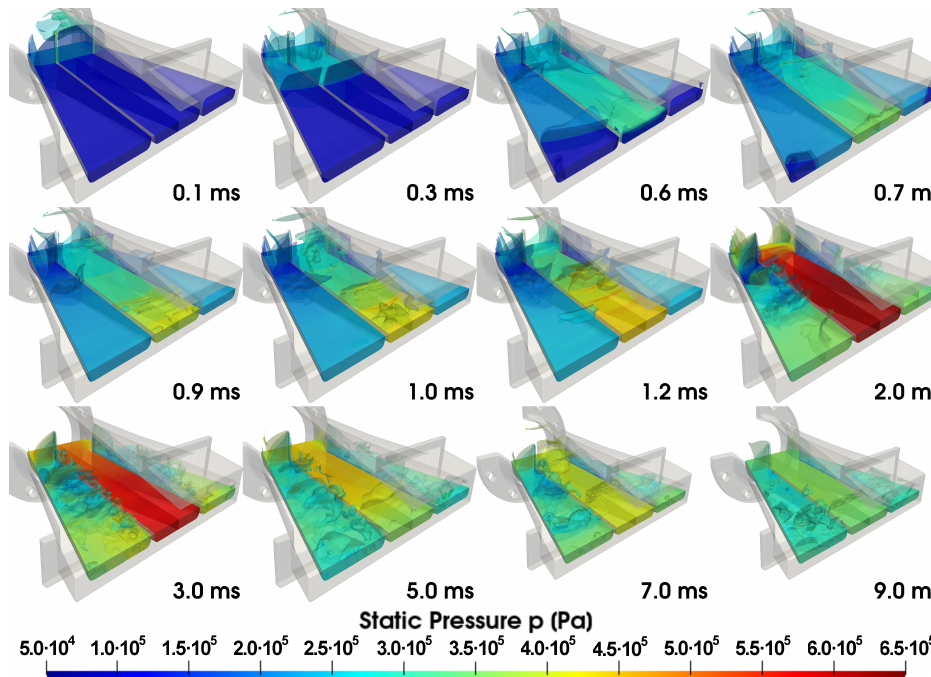
Figure 15. Snapshots of pressure contour plots for 12 time